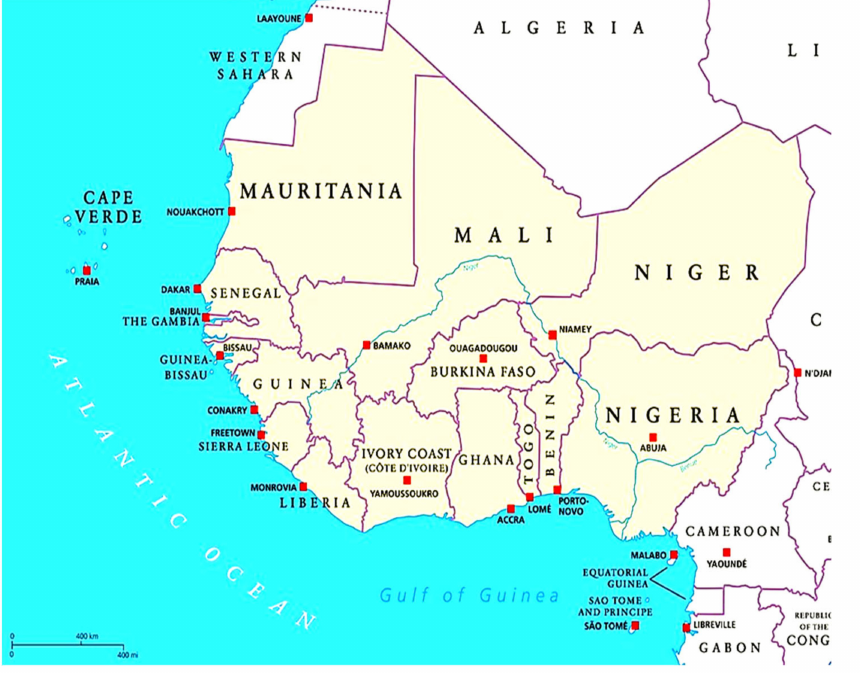
Figure 1. Map of countries in the West African